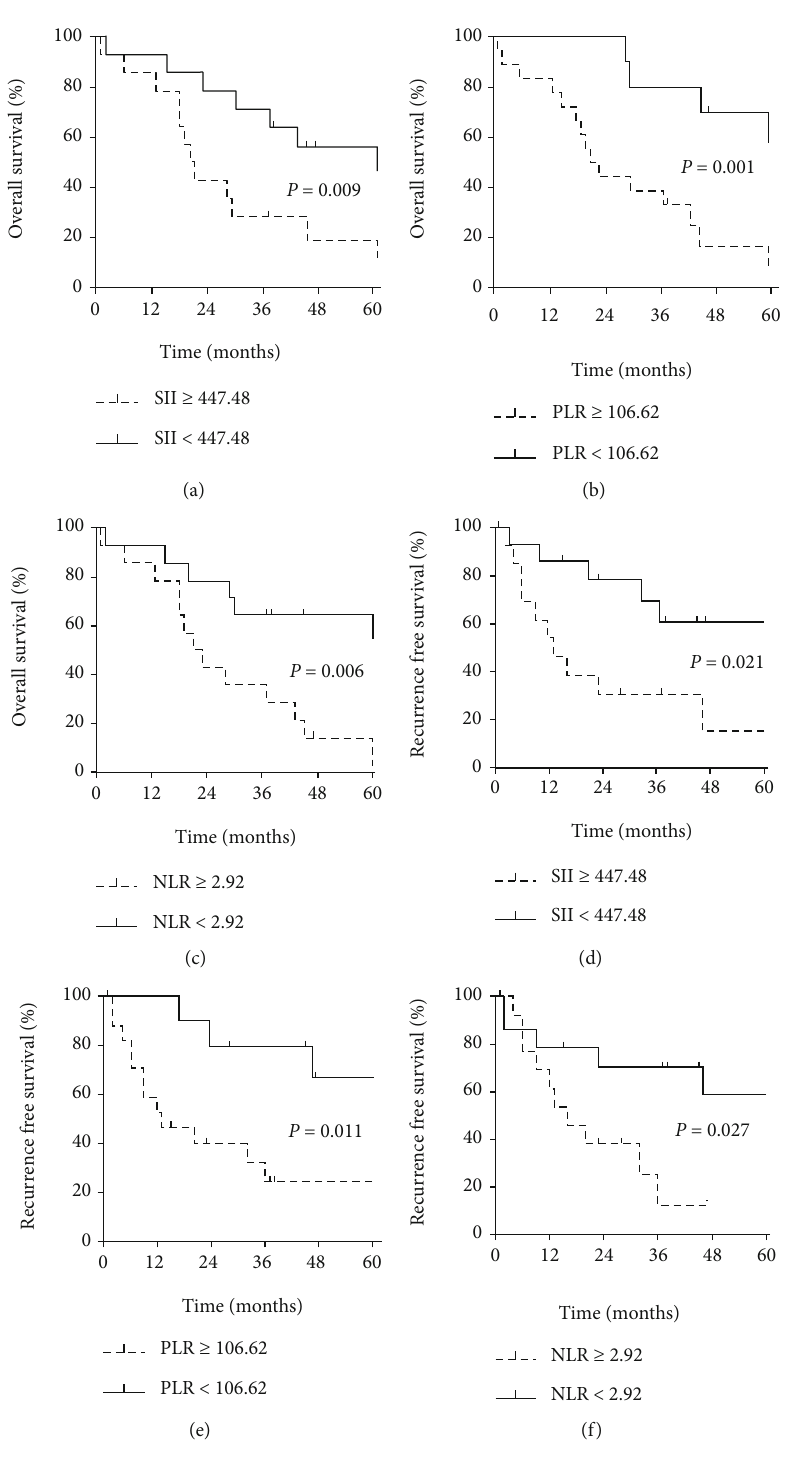
Figure 1: Overall survival curves after LT for iCCA patients classi fi ed by (a) SII, (b) PLR, and (c) NLR; recurrence-free survival curves after LT for iCCA patients classi fi ed by (d) SII, (e) PLR, and (f)